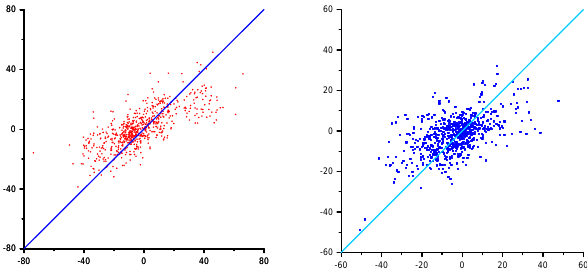
Figure 14 Scatter plot of the simulated (vertical axe) and observed (horizontal axe) surface currents. Left and right plots correspond to zonal and meridional components of the current velocity respectively.